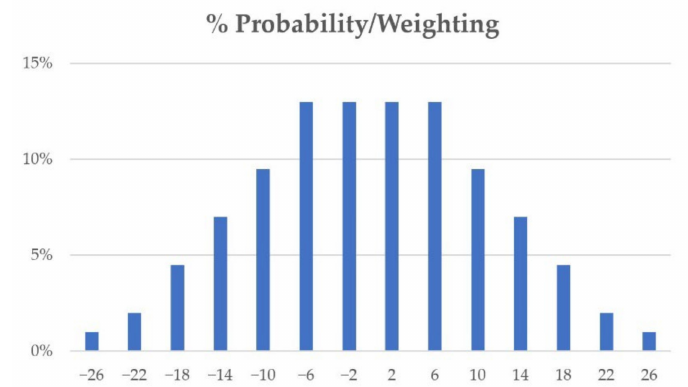
Figure 13. Probability/weighting of each yaw angle.